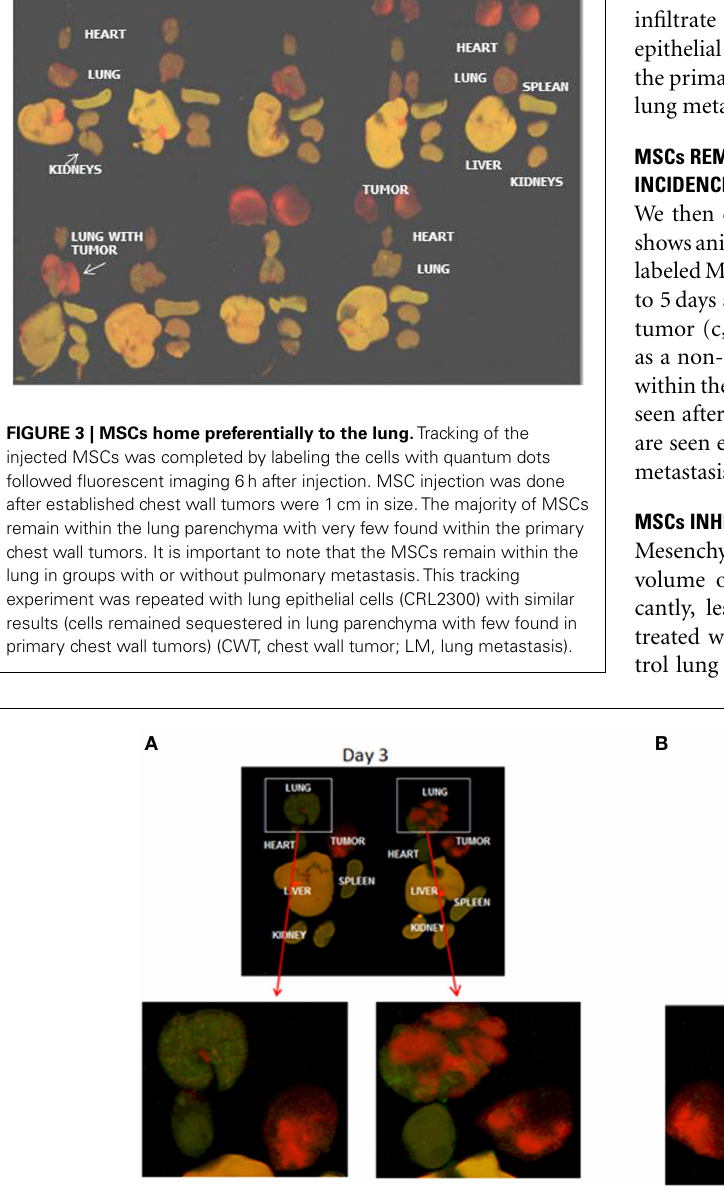
FIGURE 4 | Infrared whole mount images of mouse organs. Red color indicates labeled tumor cells. MSCs are labeled green.Tumor = chest wall tumors from the rib injection site, which are completely red with no engrafted MSCs. Organs from two different mice on day 3 and day 5 after injection, are labeled. A-day 3 after MSC delivery. Red lung metastasis is seen in the top right image. Green MSCs are seen infiltrating the lung.The